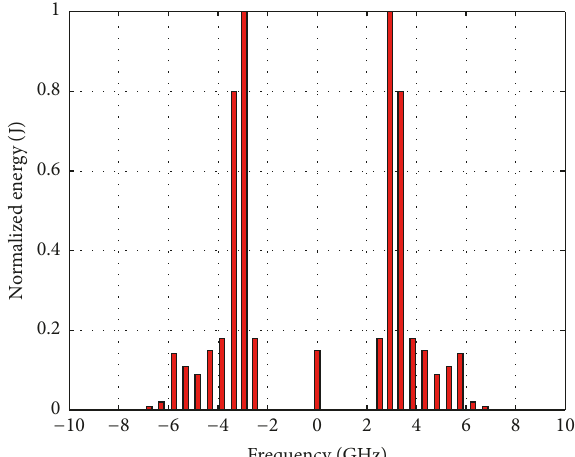
Figure 5: Poles normalized 𝐸 levels with frequency.